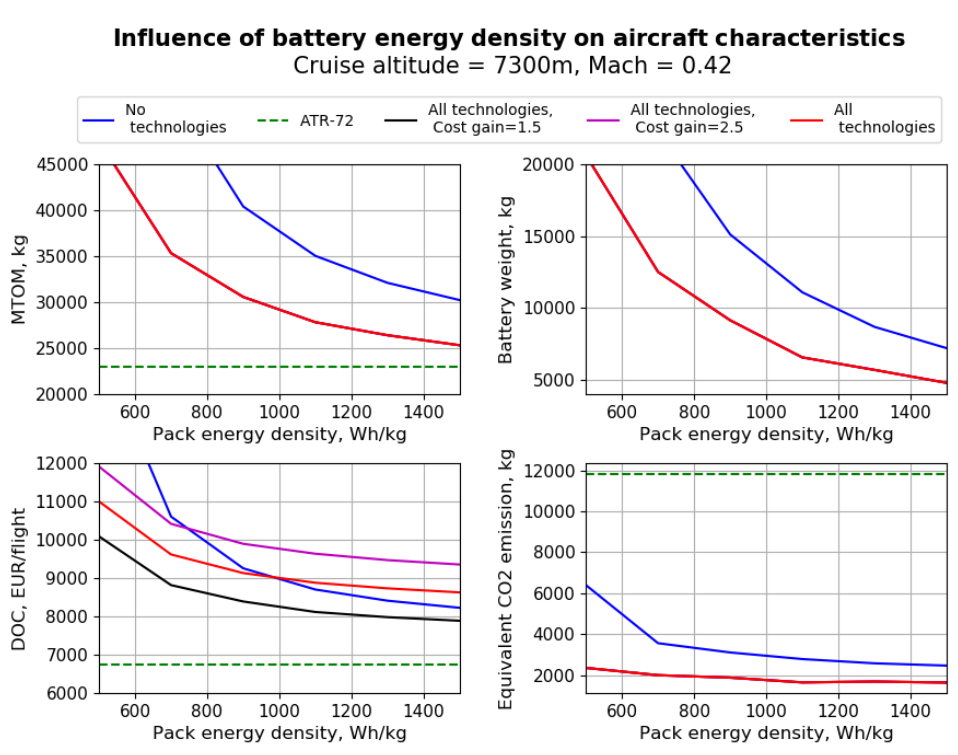
Figure 16. Sensitivity to the battery energy density based on minimum DOC